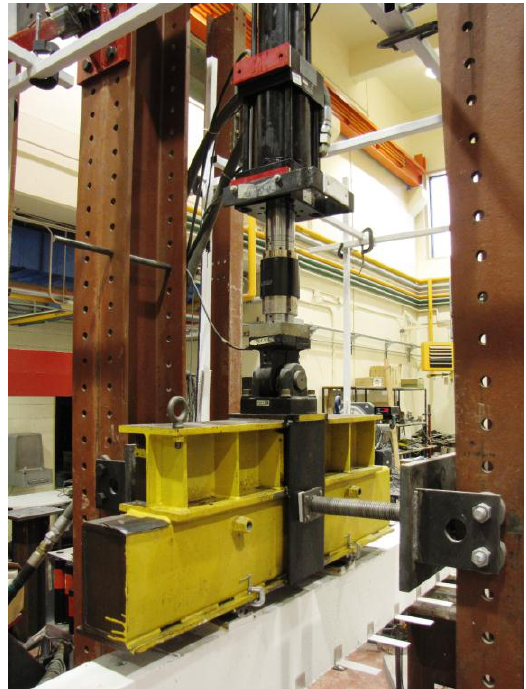
Figure 1. Spreader beam (in yellow) attached to a hydraulic actuator (in black and